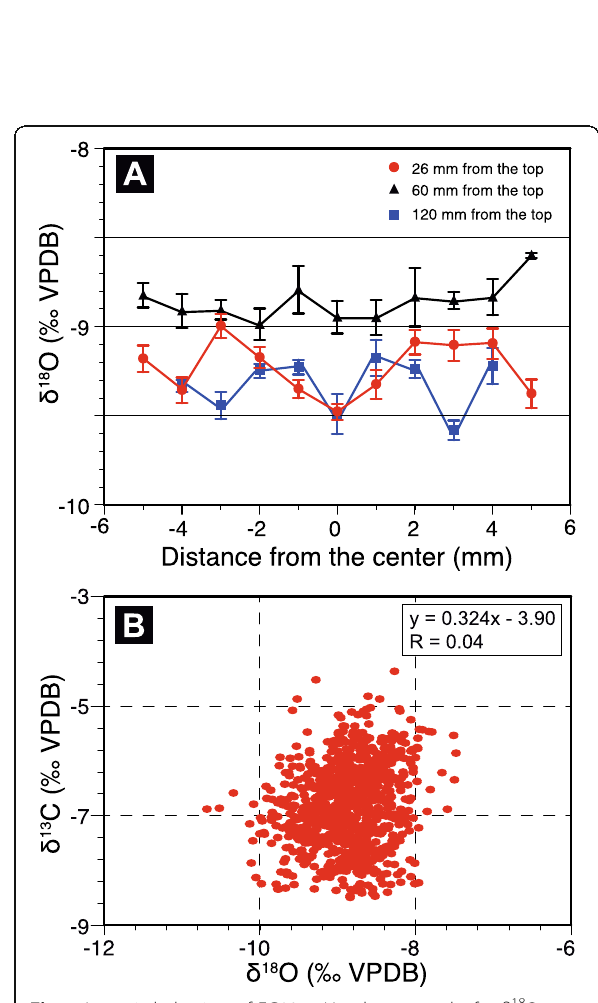
Fig. 4 Isotopic behaviors of FG02. a Hendy test results for δ 18 O C at three growth lines, 26 mm (red), 60 mm (black), and 120 mm (blue) from the top. Subsamples were collected at 1-mm intervals from the central growth axis. b Covariance between δ 18 O and δ 13